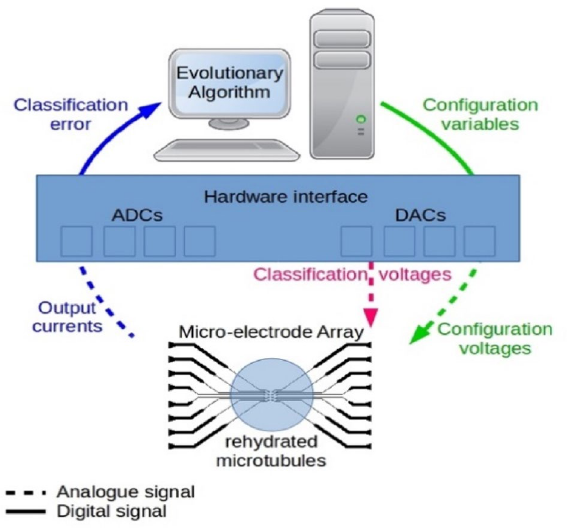
Figure 7. Schematic diagram of an EiM processor described in the text.